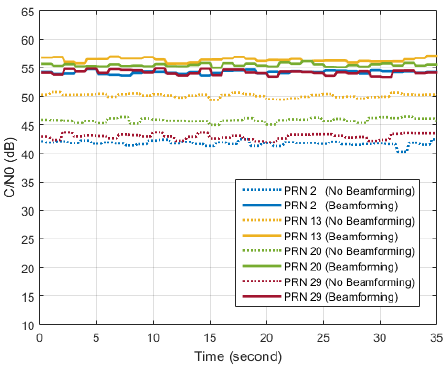
Figure 23. Results of C/N0 with beamforming (solid lines) and without beamforming (dotted lines).